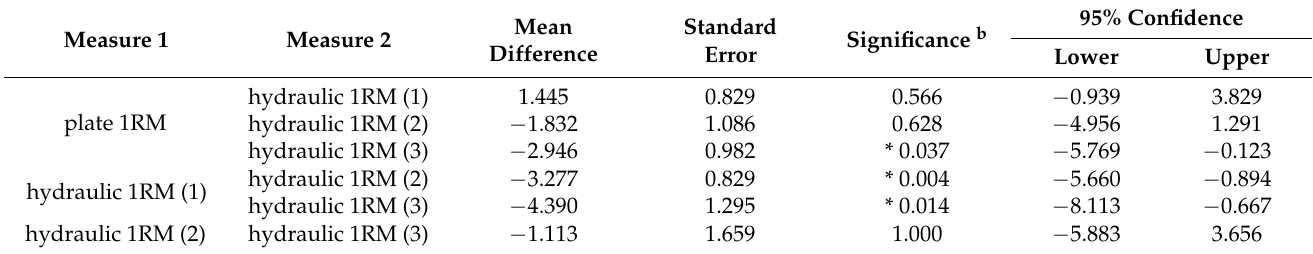
Table 2. Paired comparison of plate 1RM and hydraulic 1RMs.